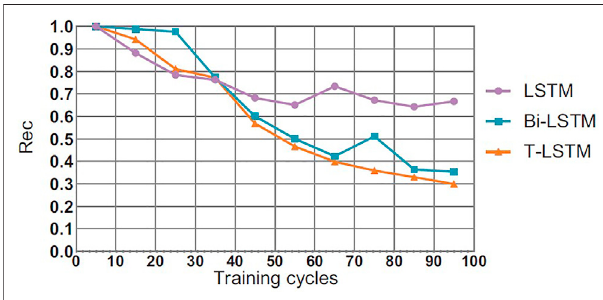
FIGURE 6 | Comparison of convergence LER results between T-LSTM and BI-LSTM and LSTM.